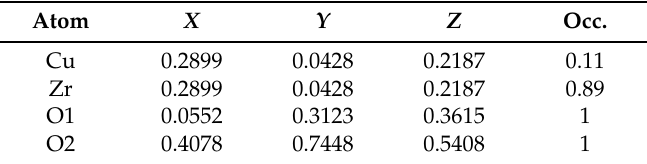
Table 2. Fractional atomic coordinates and